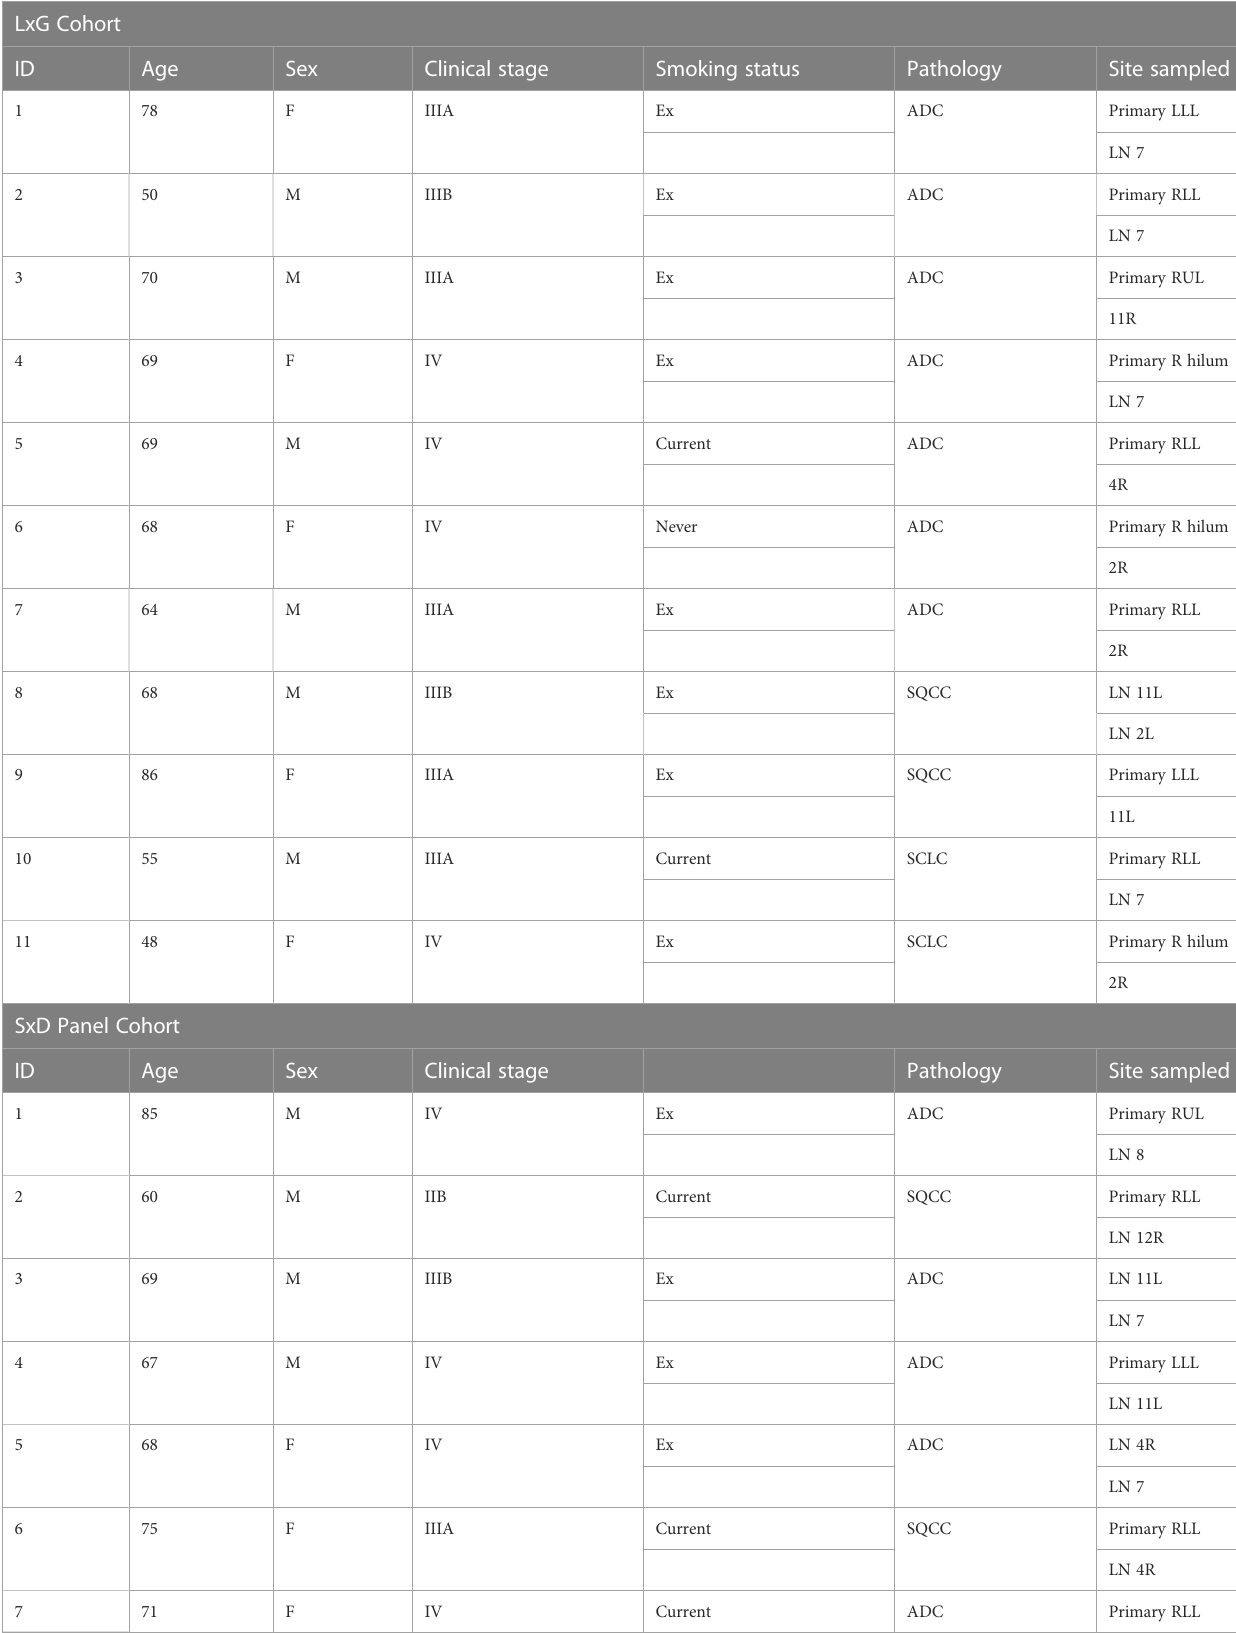
TABLE 1 Patient